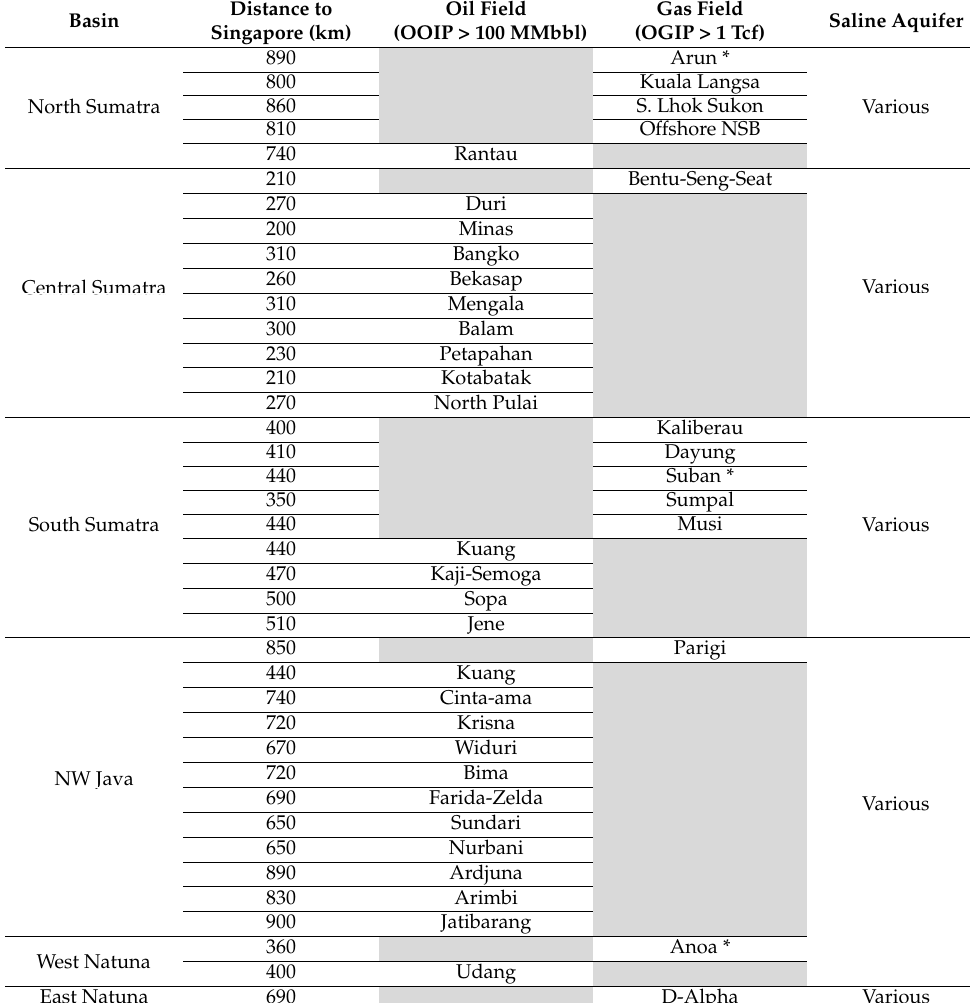
Table 3. Major Indonesian reservoirs within 1000 km from Singapore.